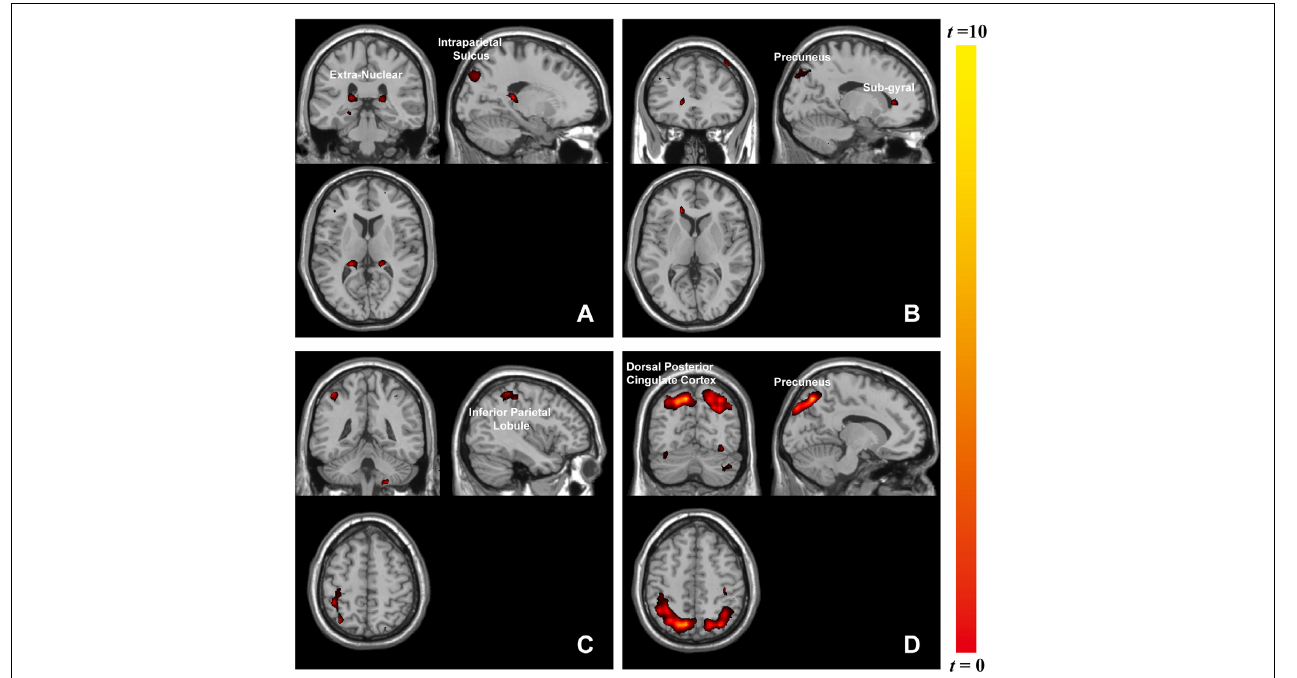
FIGURE 3 | Brain activation in contrasts of microexpressions following emotional contexts. When target was anger: (A) negative context > neutral context, extranuclear ( x = 27, y = –39, z = 15), intraparietal sulcus ( x = 18, y = –84, z = 36), (B) positive context > neutral context, precuneus ( x = 24, y = –75, z = 39), subgyral ( x = 33, y = –78, z = –6); when target was neutral: (C) negative context > neutral context, inferior parietal lobule ( x = 42, y = –42, z = 54), (D) positive context > neutral context, precuneus ( x = 12, y = –72, z = 48), dorsal posterior cingulate cortex ( x = –18, y = –84, z =